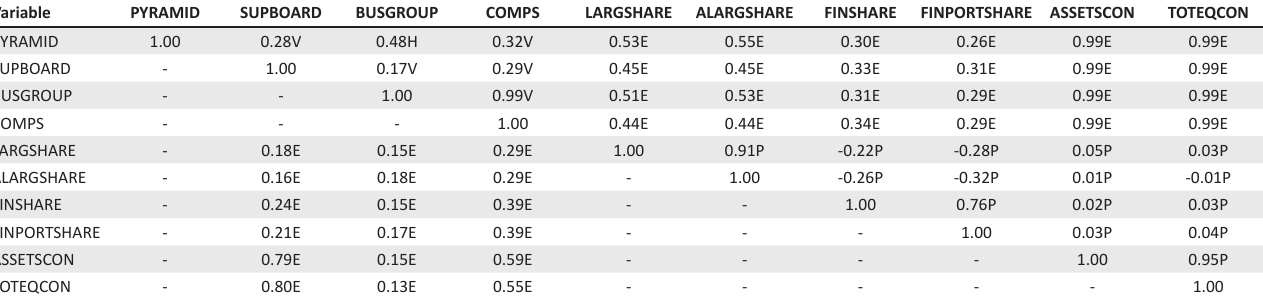
TABLE 4: Correlation matrix of selected variables. Variable PYRAMID